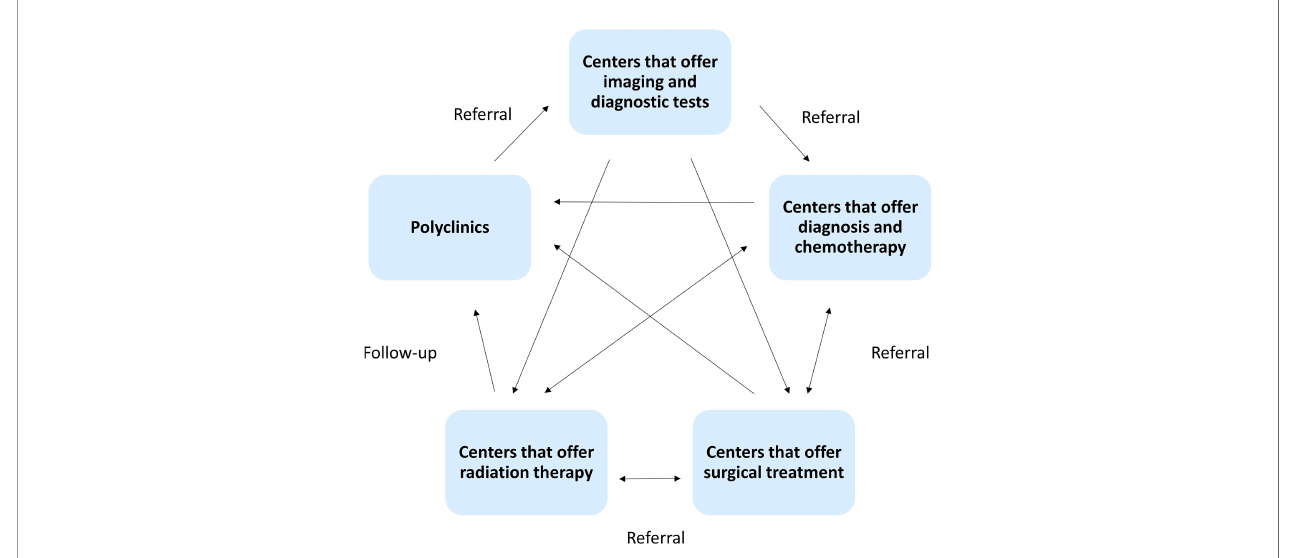
FIGURE 5 | The treatment journey of a cancer patient in Armenia. This diagram aims to highlight the multiple referrals that occur in a patient ’ s treatment process. Not all patients go through the same process and in the same